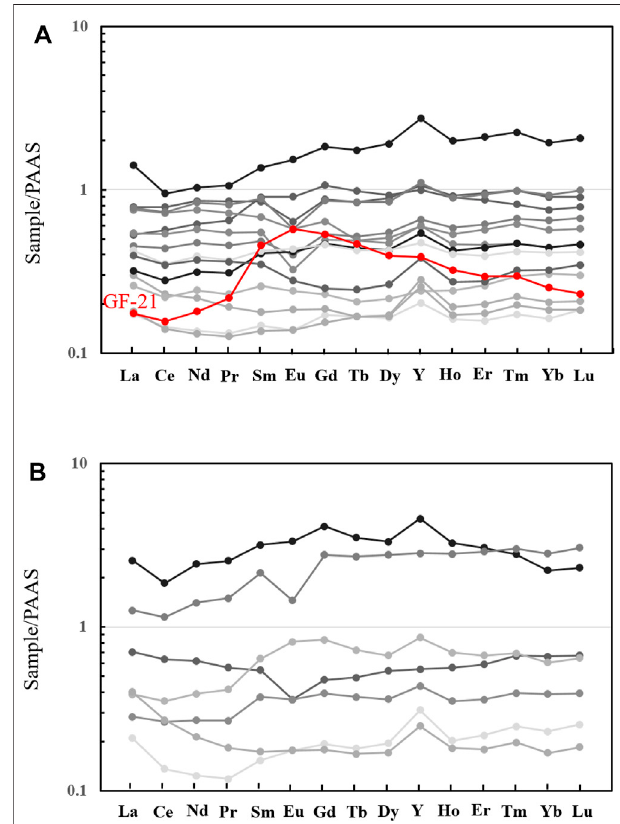
FIGURE 3 | PAAS-normalized REE patterns of the shale samples from the Permian Gufeng Formation at the Putaoling section. (A) and (B) are the upper member and lower member,